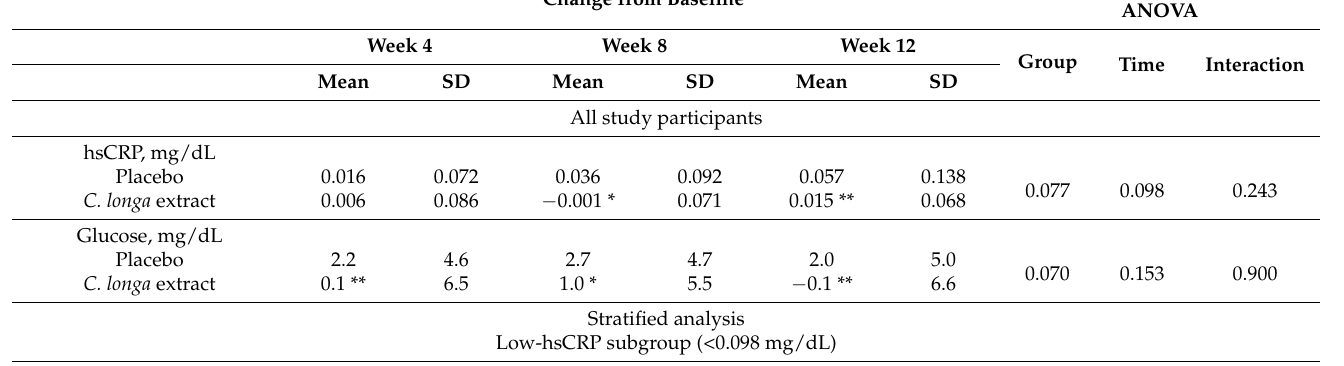
Table 4. Effect of C. longa extract on serum hsCRP and glucose levels stratified by baseline hsCRP levels in the study 1 1 . Change from Baseline Week 4 Week 8 Week 12 Mean SD Mean SD Mean